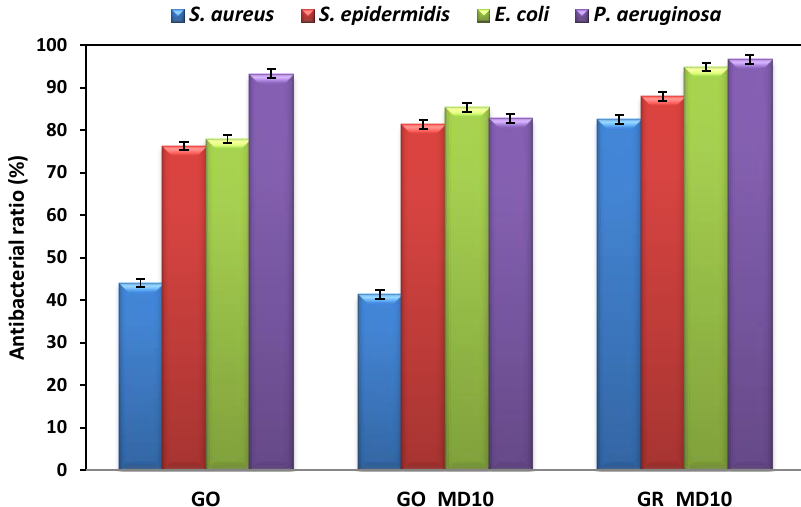
Figure 8. Antibacterial ratio of hybrid materials and GO against bacteria.